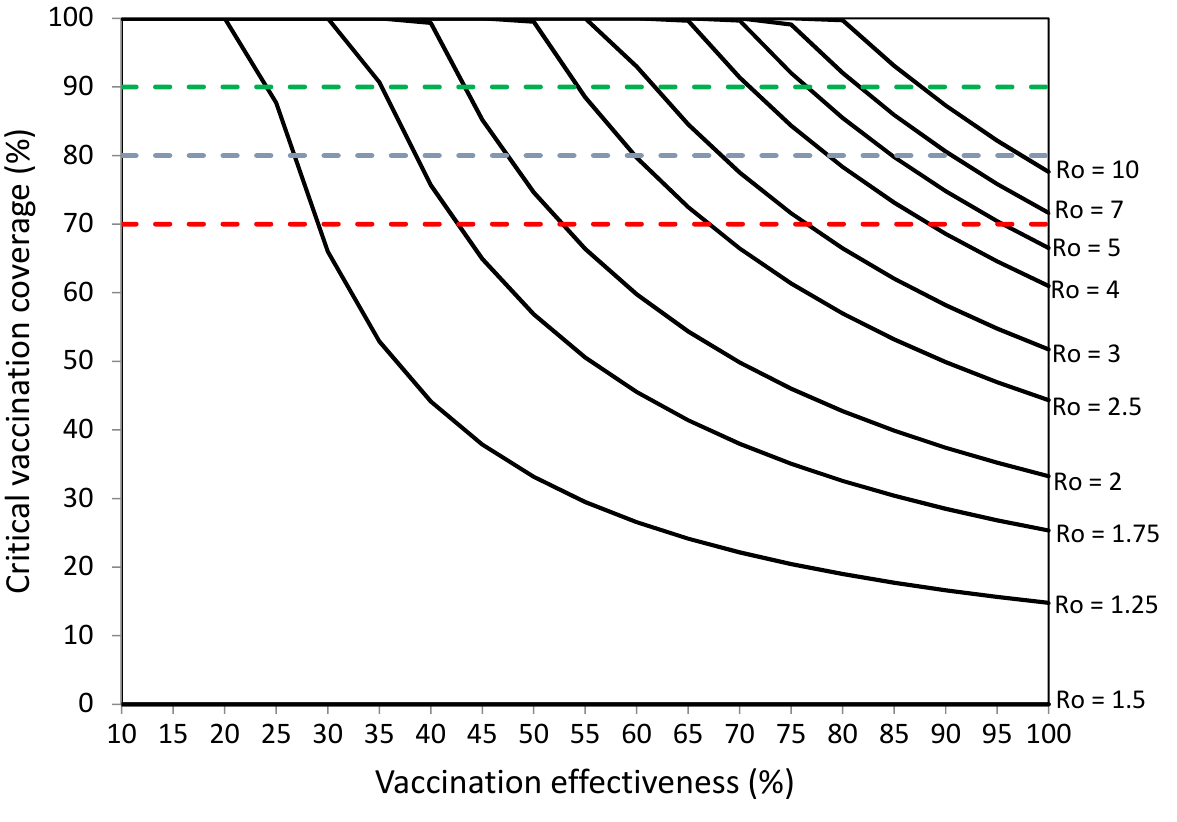
Figure 5. Vaccination coverage (%) required to establish herd immunity against SARS-CoV-2 with different basic reproductive numbers (R o ) by vaccination effectiveness (%) in a population with 20% prevalence of protected individuals and 9.8% of infections among vaccinated individuals. Objectives of vaccination coverage of 70%, 80%, and 90% are indicated with dashed red, blue, and green lines, respectively.